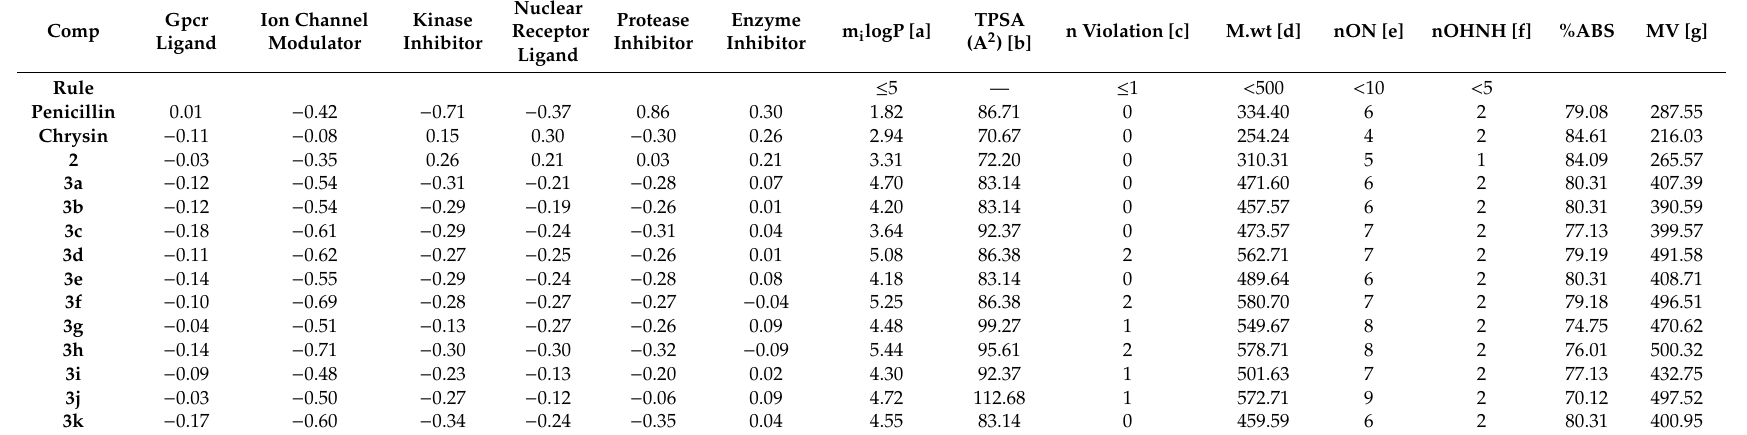
Table 5. Pharmacokinetic properties of chrysin, its 2-hydroxy-3-chrysino dithiocarbamate derivatives ( 3a – k ) and standard drug